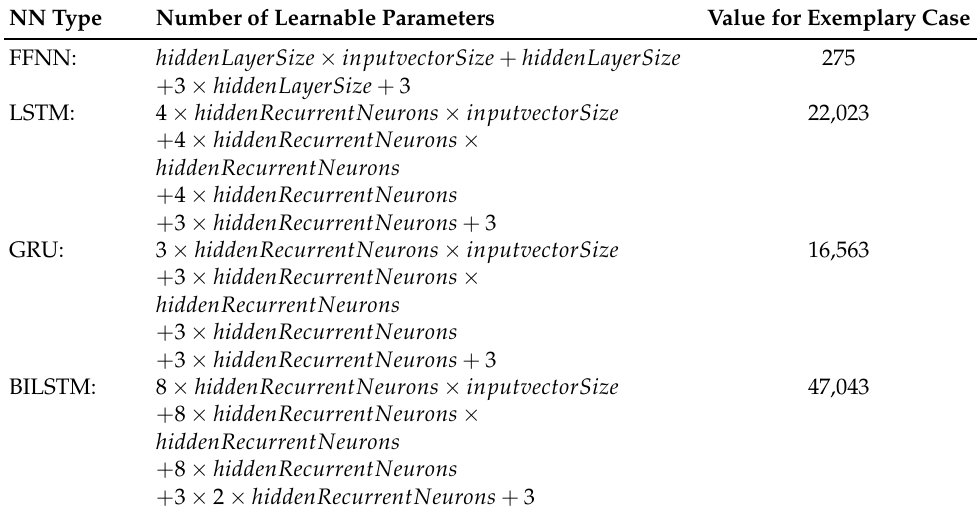
Table 4. List of mocap sequence scenarios used for the